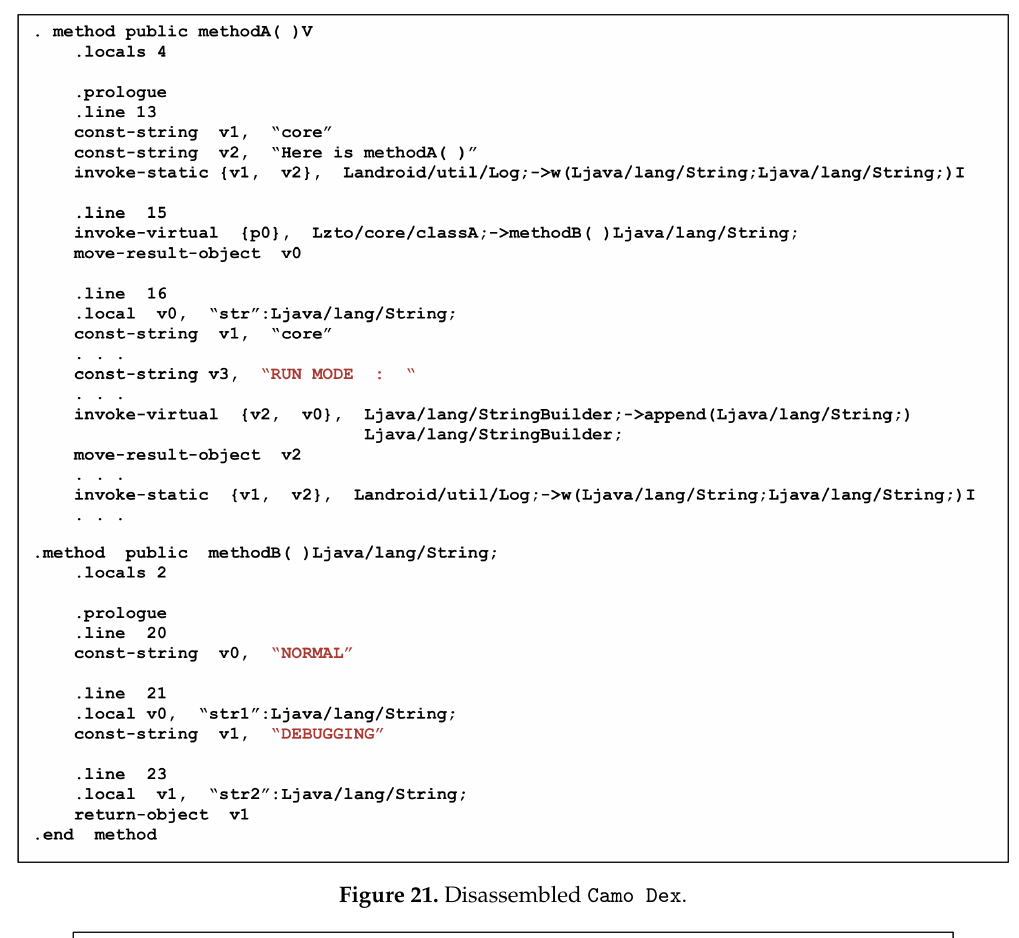
Figure 21. Disassembled Camo Dex .